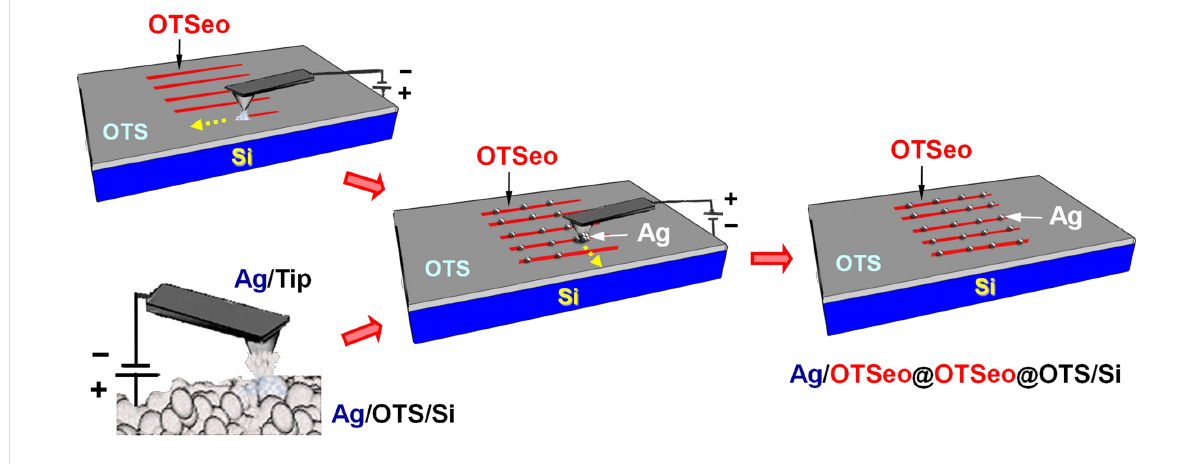
Figure 4: Scheme of serial-contact electrochemical metallization of selected sites within the OTSeo lines of a OTSeo@OTS/Si template nanopattern: (top left) inscription of OTSeo lines with a conductive SFM tip (CNL process); (bottom left) loading of silver on a conductive SFM tip by contact electro- chemical transfer from a thin silver film evaporated on a OTS/Si monolayer; (center) selective-contact electrochemical transfer (CET) of silver from the silver-coated tip to selected sites along the OTSeo lines, implemented by moving the positively biased tip (mobile anode) across the OTSeo lines that play the role of cathode for metal deposition (see text); (right) resulting pattern-within-pattern array of silver/monolayer nanodots (Ag/OTSeo@OTSeo@OTS/Si denotes Ag/OTSeo sites within metal-free OTSeo regions located within the unmodified OTS/Si monolayer). As in the parallel CET process (Figure 1), no metal is transferred from tip to surface in a dry atmosphere and in the absence of an appropriate voltage bias (see Supporting Information File 1, Figure S1).